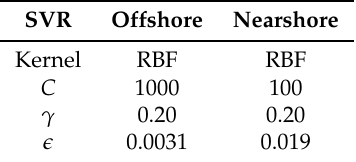
Table 2. Support Vector Regression parameters used other than